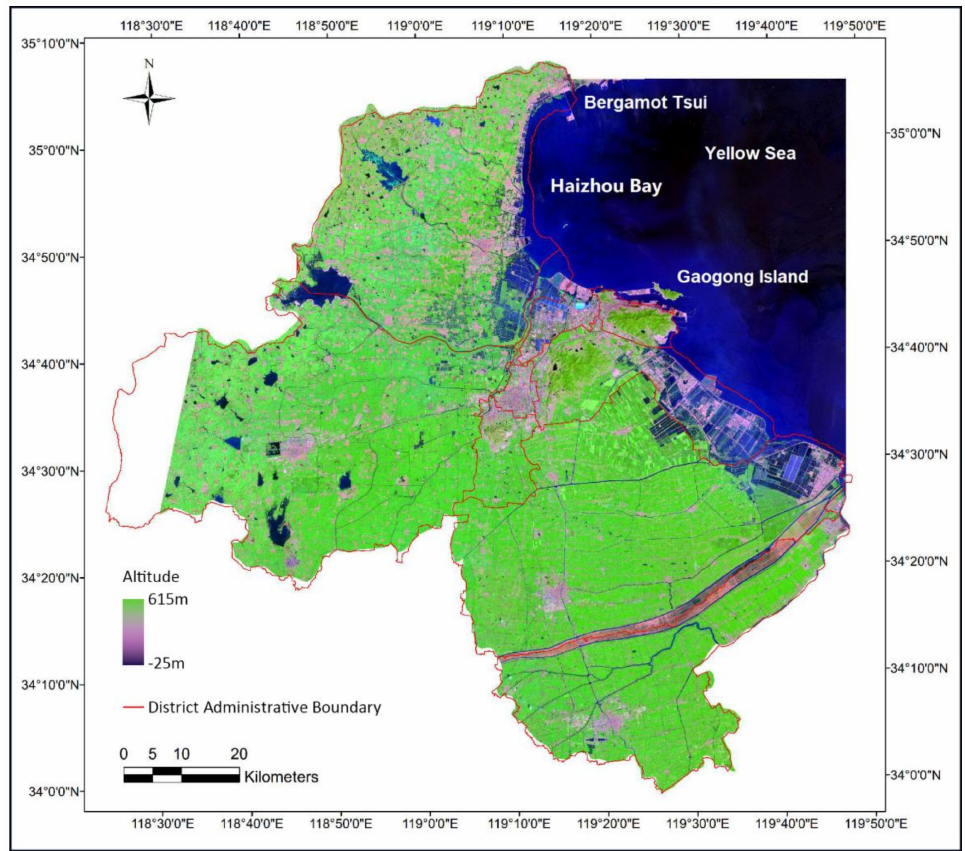
Figure 1. Map of the study area, Haizhou Bay, in 2016. Haizhou Bay is bound by Laoyeding in the north, Yuntai Mountain in the south, and an alluvial marine plain in the west. The rivers entering the bay along the coast include Xiuzhen River, Longwang River, Qingkou River, Xinshu River and Qiangwei River; the latter two are called Linhong River after their convergence. Qinshan Island and the East–West Islands are located in Haizhou Bay, and Pingshan Island, Dashan Island and Cheniushan Island are located outside the bay. These islands are all bedrock islands. Transportation along the Gulf Coast is convenient: it is the eastern starting point of the Longhai railway, which crosses eastern China, and is the shortest sea exit for the nine provinces (autonomous regions) in the northwest and central plains. It is known as the “bridgehead at the eastern end of the Eurasian Continental Bridge”, and is an important transportation hub linking north and south, and east and west, in